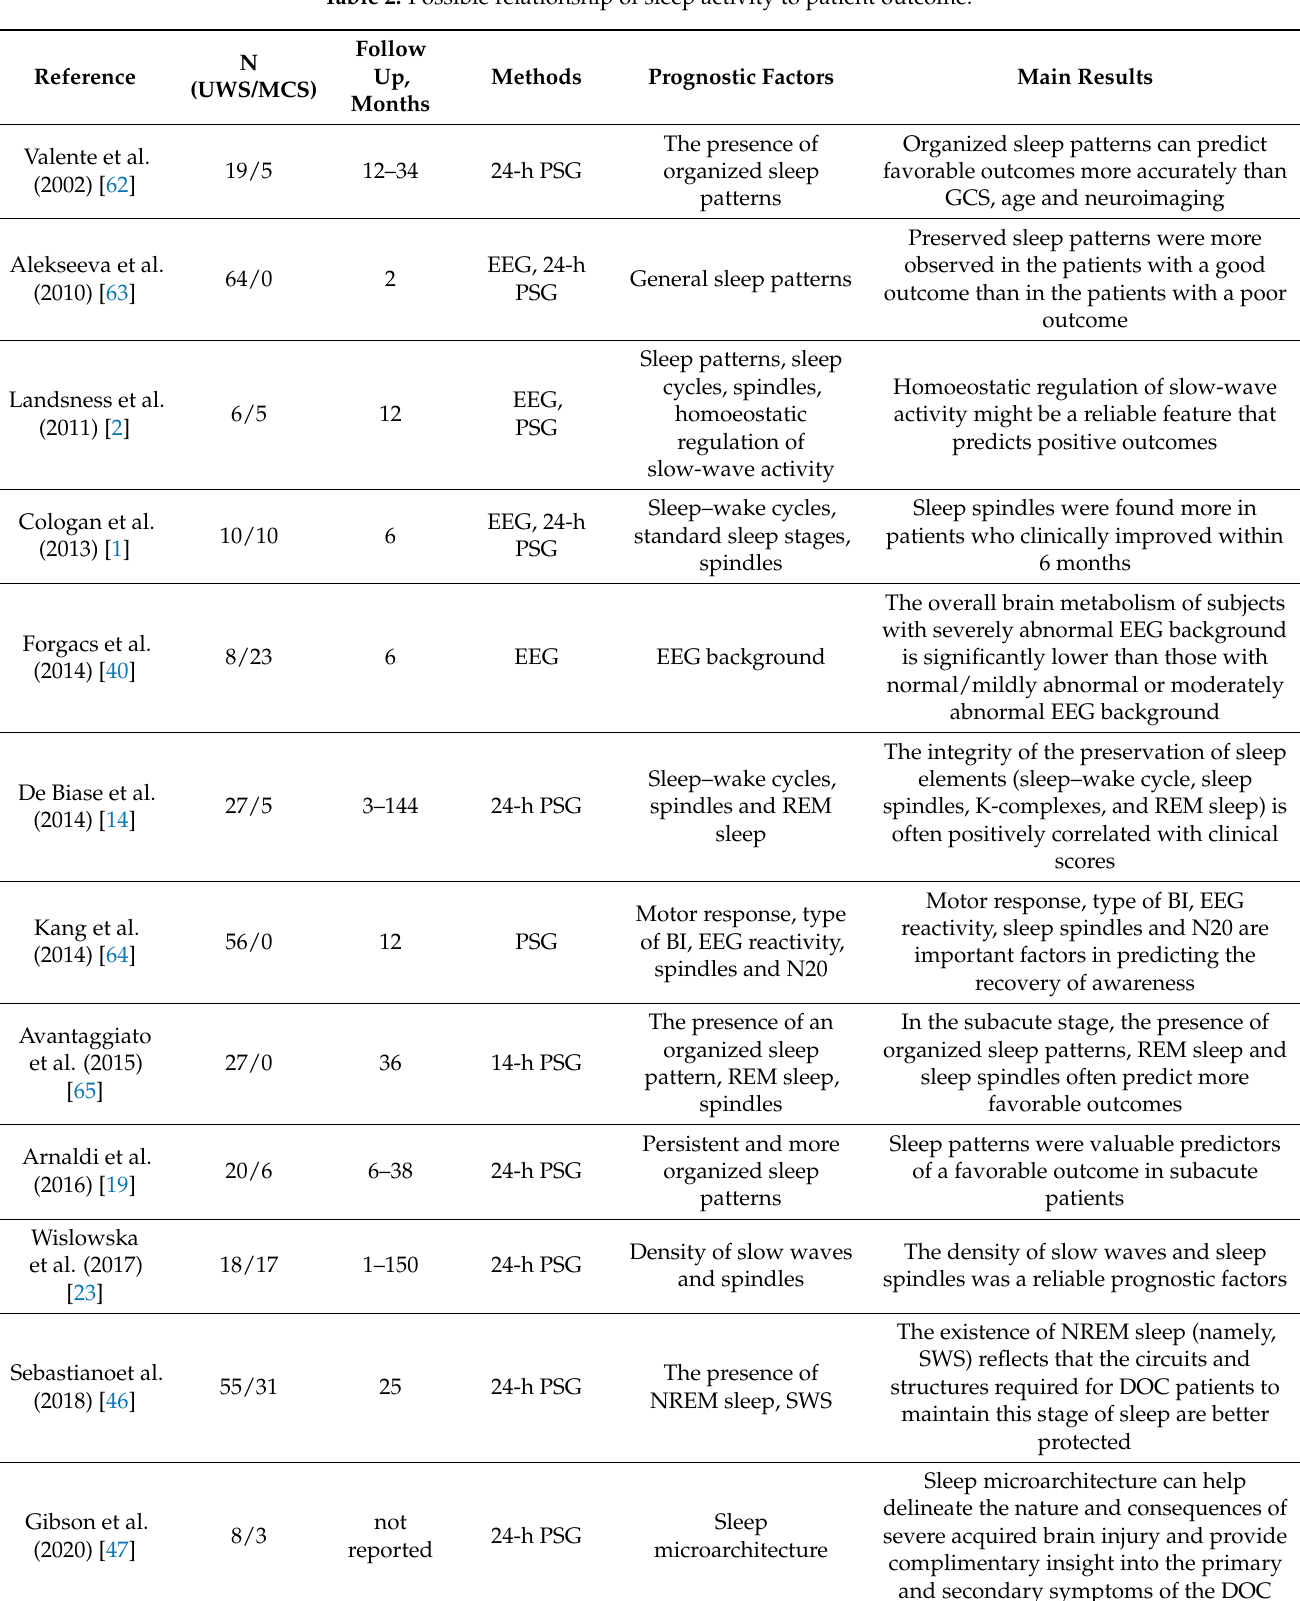
Table 2. Possible relationship of sleep activity to patient